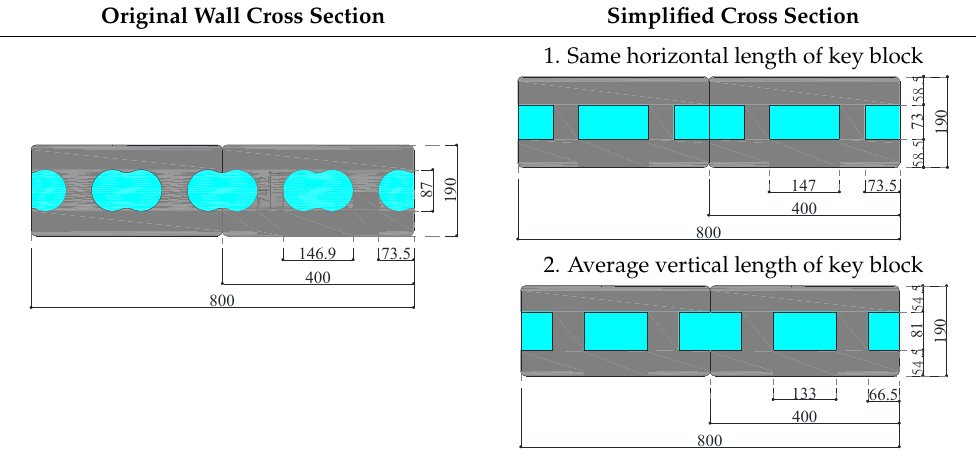
Table 6. Simplification method of cross-sectional area of key block (Specimen PS).